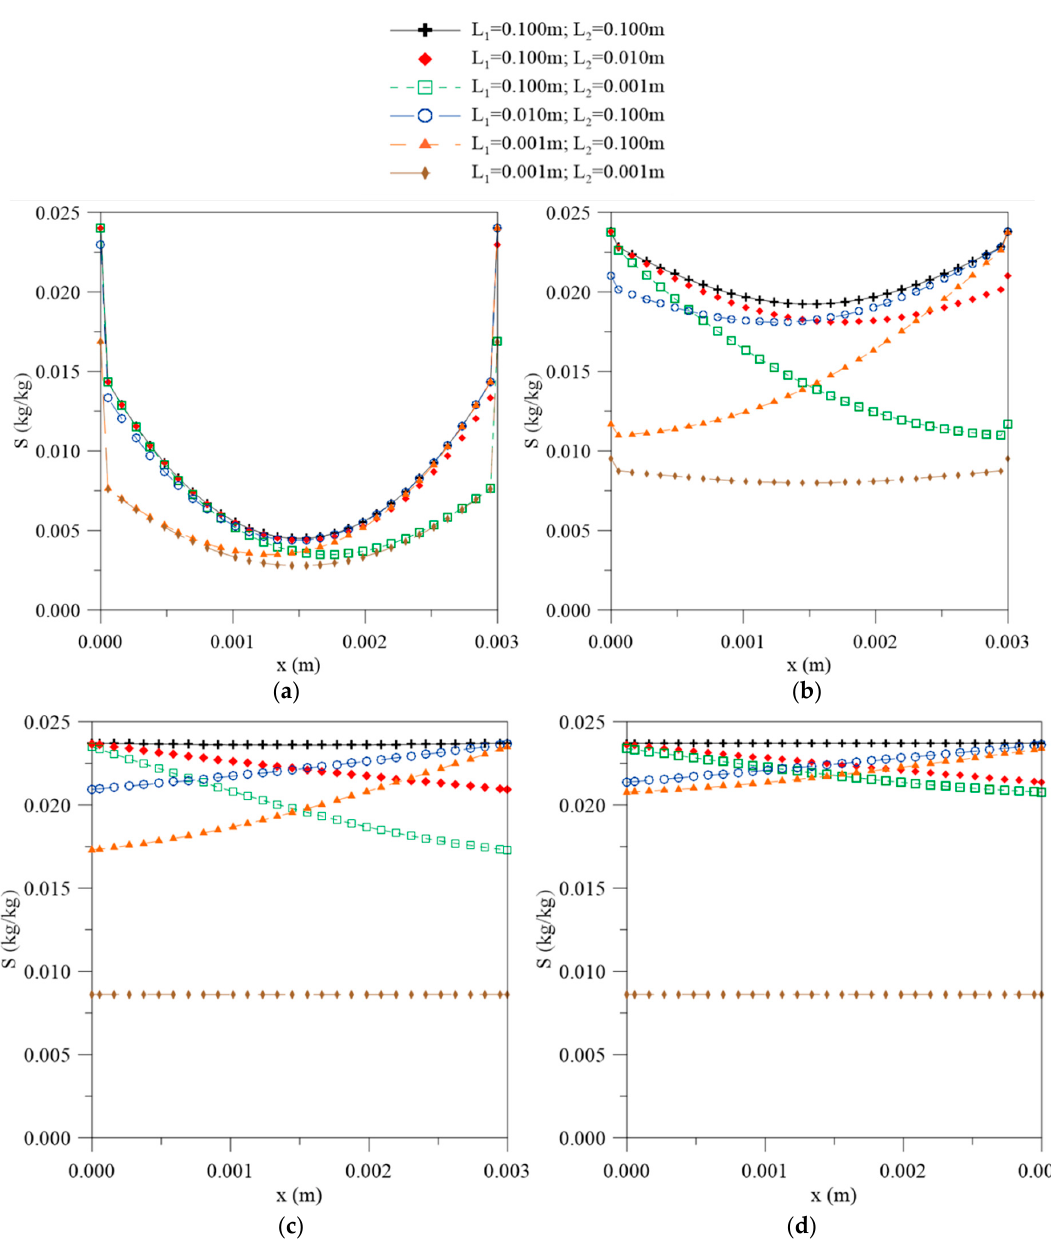
Figure 6. Bound water molecule concentration as a function of the position inside the material at different process times: ( a ) 56, ( b ) 195, ( c ) 500, and ( d ) 1944 h.